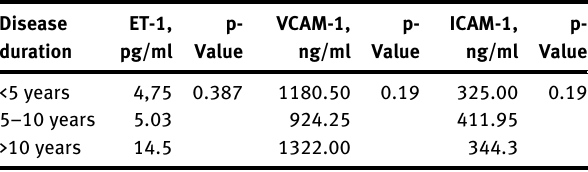
Table  : Differences in ET-  , ICAM-  , and VCAM-  mean concen- trations depending on disease